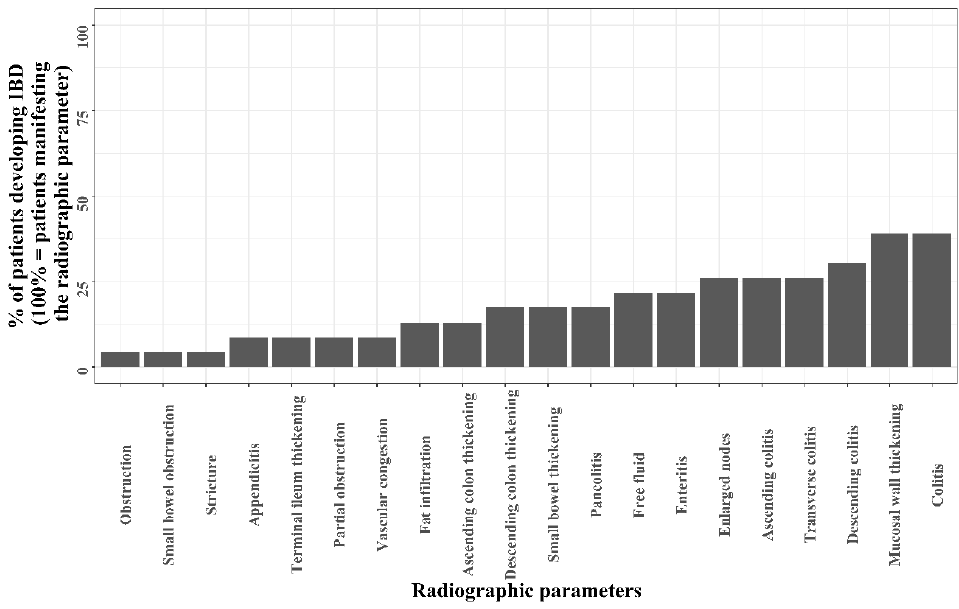
Figure 3. Frequency of the patients developing IBD as per different radiographic parameters. On a univariable analysis, age (per 5 years, HR 0.92, CI 0.89 – 0.95, p < 0.001], colitis on